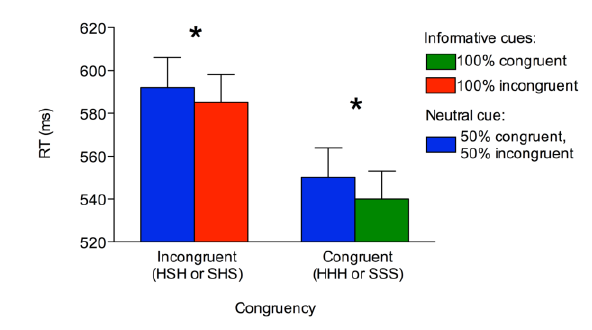
Figure 2 Manual reaction times reported for each ex- perimental condition. Asterisks denote p < .05.